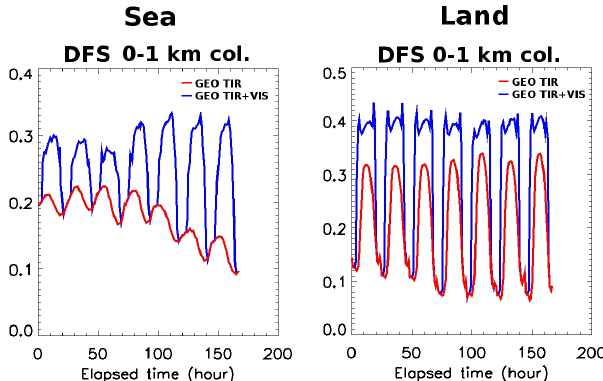
Figure 11. As in Fig. 9 but for the sea pixels (first column) and land pixels (second